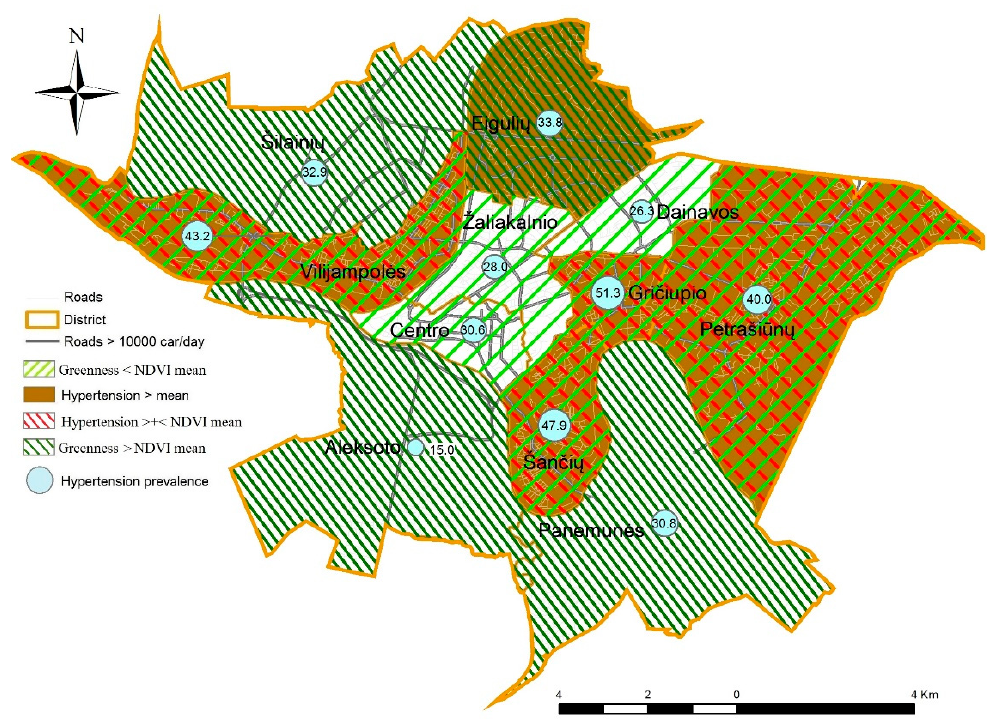
Figure 1. Spatial distribution of exposure to greenness (by mean) and the unadjusted prevalence of hypertension (%) at Kaunas district level.